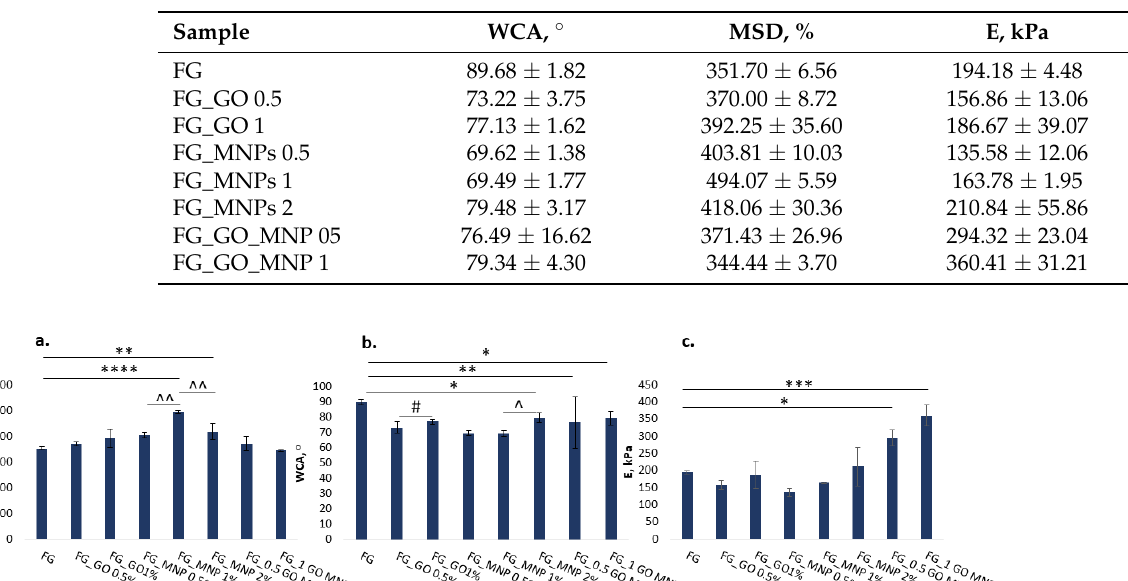
Table 2. Summarized results of the contact angle measurements, maximum swelling degree, and tensile Young’s modulus.